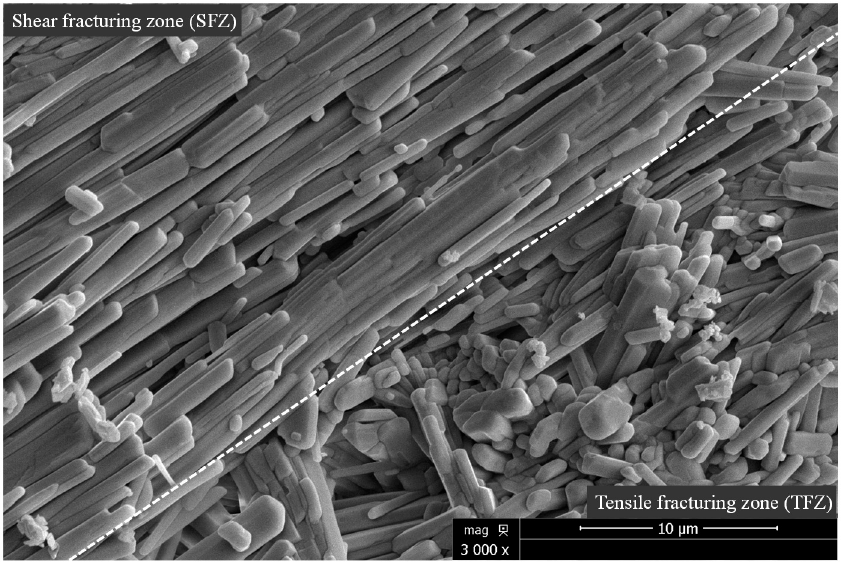
Figure 5. SEM scanning image of SFZ and TFZ.